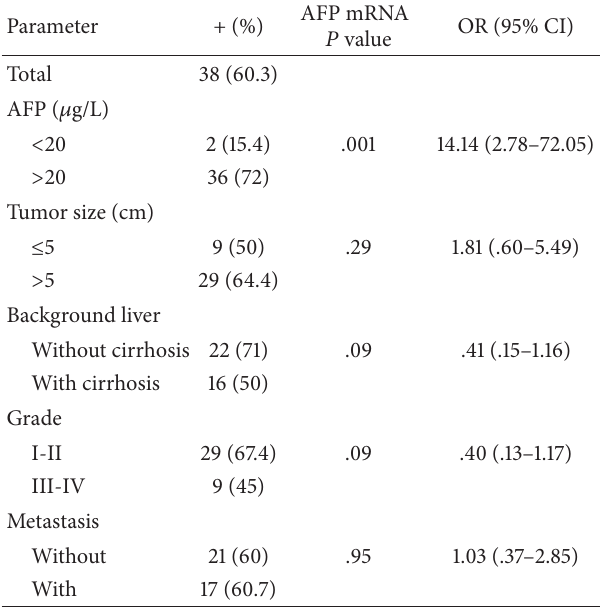
Table 4: Relationship between AFP mRNA expression and clinico- pathological parameters in HCC